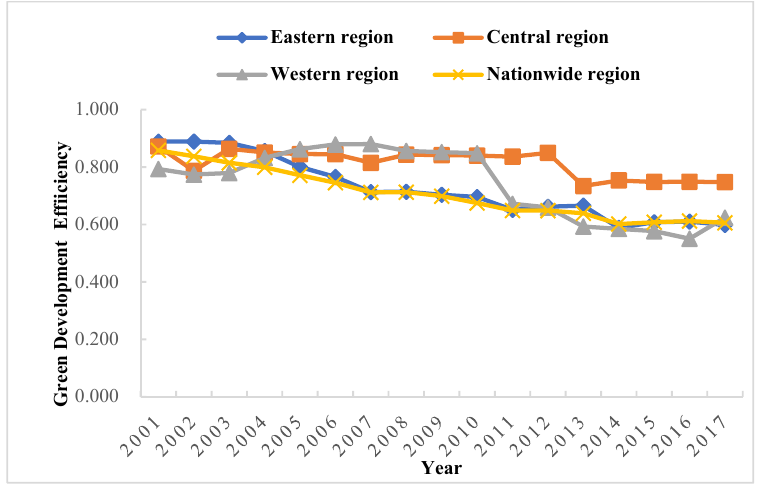
Figure 3. Green development efficiency under the group frontier of east, central, and west China. Table 2. China’s average inter-provincial green development efficiency and technology lag ratio under different